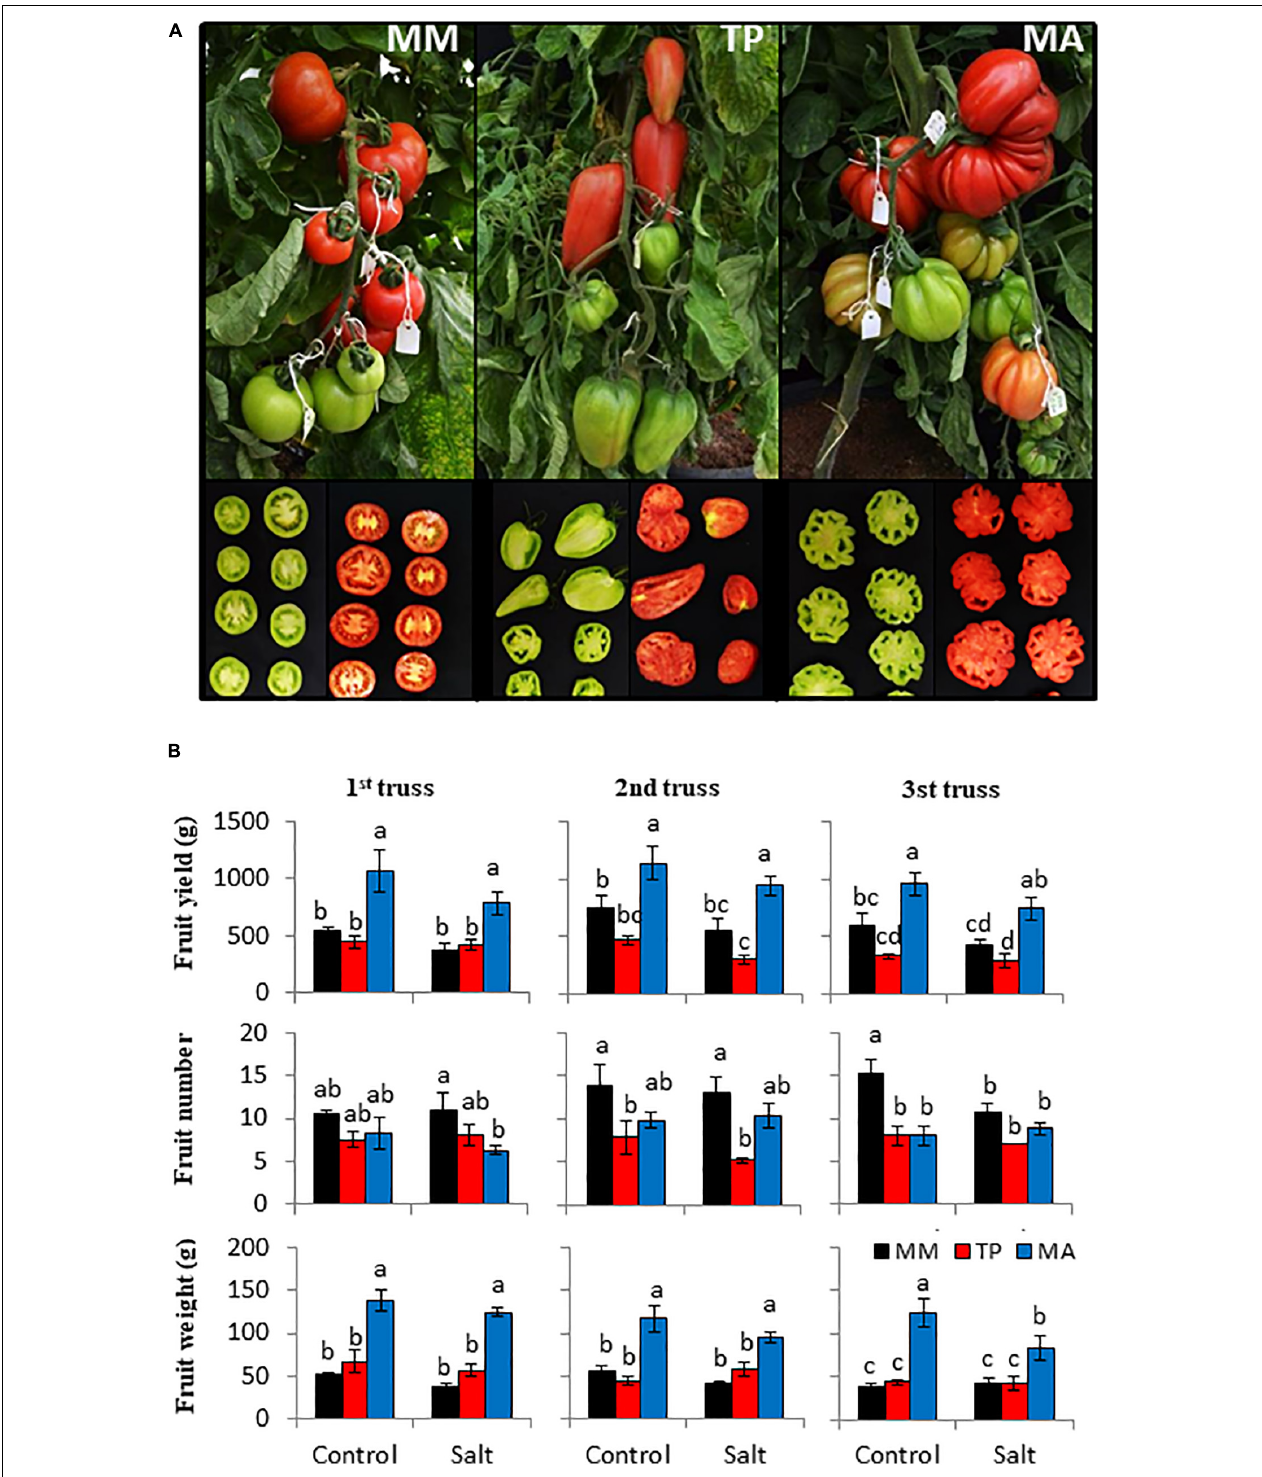
FIGURE 1 | Agronomic response of “Moneymaker” (MM) and two traditional varieties, “Tomate Pimiento” (TP) and “Muchamiel Aperado” (MA), to moderate salinity levels (50 mM NaCl). (A) Representative images of the fruits from the first truss showing the different fruit morphological characteristics of both landraces with respect to MM. (B) Fruit yield (g FW), fruit number, and fruit weight (g FW) from the first three trusses of plants grown in control and salt for 60, 70, and 80 days of 50 mM NaCl treatment. Values are expressed as means ± SE of seven plants per variety. Different letters indicate statistically significant differences according to Tukey’s test ( p <